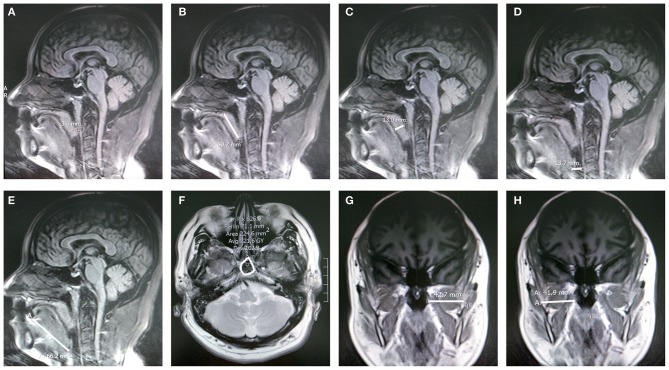
MRI measurements. (A) Retropalatal distance on a sagittal T1-weighted image. (B) Palatal length on a sagittal T1-weighted image. (C) Palatal thickness on a sagittal T1-weighted image. (D) Retroglossal space on a sagittal T1-weighted image. (E) Tongue length on a sagittal T1-weighted image. (F) Cross-sectional area of the retropharyngeal region on an axial T2-weighted image. (G,H) Lateral pharyngeal wall thickness on a coronal T1-weighted image.